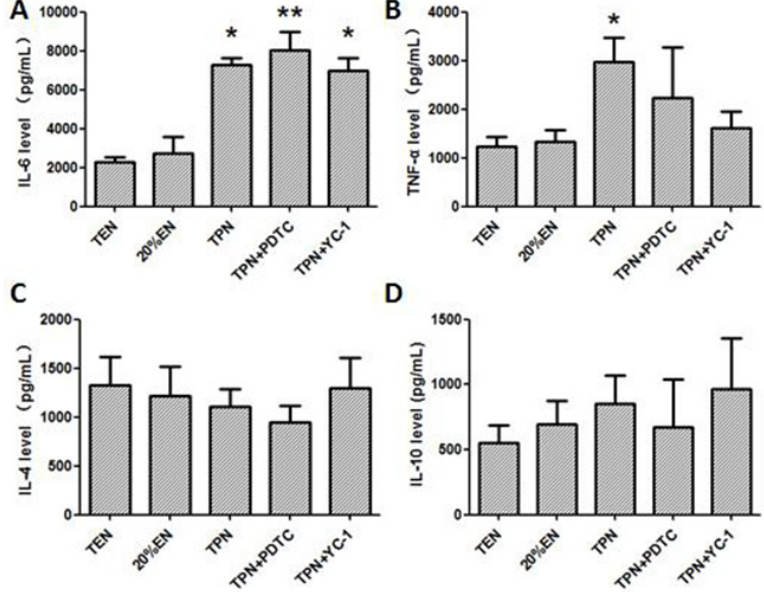
Figure 11. The analysis of inflammatory cytokine levels in intestinal epithelium tissue. ( A ) Enzyme-linked immunosorbent assay of TNF- α ; ( B ) Enzyme-linked immunosorbent assay of IL-6; ( C ) Enzyme-linked immunosorbent assay of IL-4; ( D ) Enzyme-linked immunosorbent assay of IL-10. Both TNF- α and IL-6 were significantly upregulated in the TPN group compared with TEN ( p = 0.023 and 0.030). IL-4 and IL-10 concentrations, however, showed no difference in all the groups. Additionally, TNF- α was increased in TPN+PDTC and TPN+YC-1 groups ( p = 0.009 and 0.038 compared with TEN). * p < 0.05, compared with TPN group; ** p < 0.01, compared with TPN